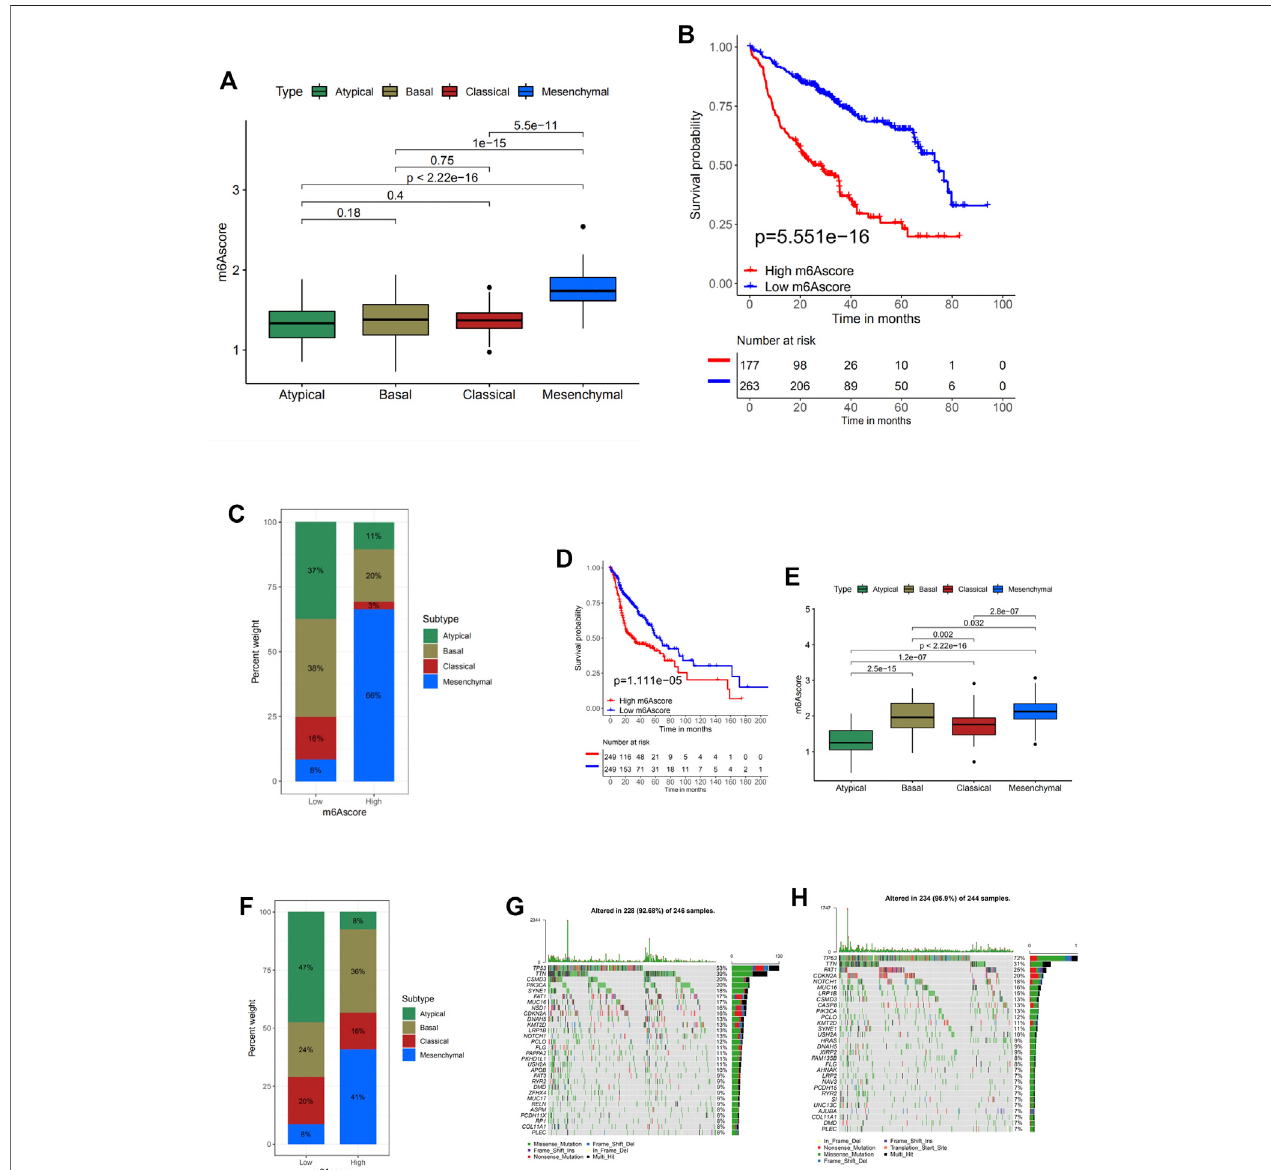
FIGURE 5 | Characteristics of m6A modi fi cation in molecular subtypes and tumor somatic mutation. (A) Differences in m6Ascore between different subtypes. The Kruskal – Wallis test was used to compare the statistical difference between four subtypes ( p < 0.0001). (B) Survival analyses for low (263 cases) and high (177 cases) m6Ascore patient groups in TCGA-HNSC cohort using Kaplan – Meier curves [hazard ratio (HR), 3.0 (2.12 – 4.21); p < 0.0001, log-rank test]. (C) The proportion of molecularsubtypeswithlowandhighm6Ascore.Atypical,green;basalsubtype,olive;classicalsubtype,red;mesenchymalsubtype,blue. (D) Survivalanalysesfor low (249cases) and high (249 cases) m6Ascorepatient groups inthe GSE65858 cohort using Kaplan – Meiercurves[HR, 1.81 (1.26 – 2.62); p (cid:1) 0.001,log-ranktest]. (E) Differencesinm6Ascorebetweendifferentmolecular subtypes. Theupperand lowerendsoftheboxesrepresenttheinterquartilerange ofvalues. Thelines intheboxes represent the median value. The Kruskal – Wallis test was used to compare the statistical difference between four molecular subtypes ( p < 0.0001). (F) The proportion of molecular subtypes with low and high m6Ascore. Atypical, green; basal subtype, olive; classical subtype, red; mesenchymal subtype, blue. (G, H) The waterfall plot of tumor somatic mutation established by those with high m6Ascore (G) and low m6Ascore (H) . Each column represents individual patients. The upper barplot shows tumor mutational burden (TMB); the number on the right indicates the mutation frequency in each gene. The right barplot shows the proportion of each variant type.